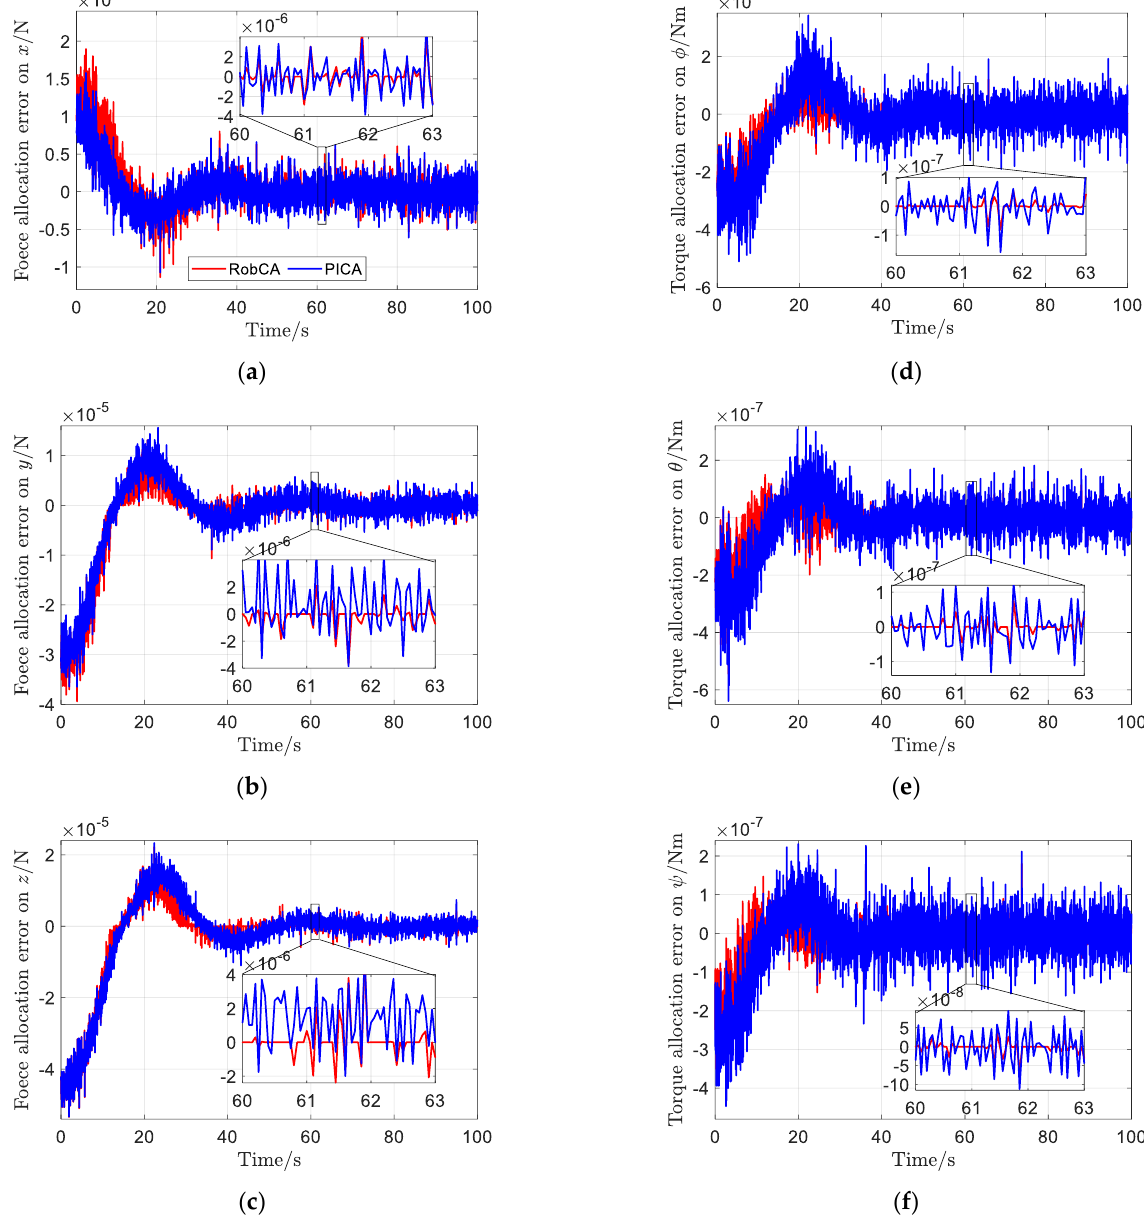
Figure 10. The nearest distance between the test mass and the electrode house with the RobCA method and the PICA method. ( a ) Force allocation error on x. ( b ) Force allocation error on y . ( c ) Force allocation error on z . ( d ) Torque allocation error on ϕ . ( e ) Torque allocation error on θ . ( f ) Torque allocation error on ψ .